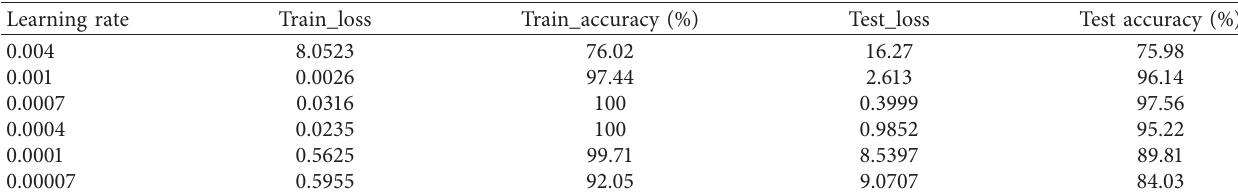
Table 3: Effect of learning rate on recognition results.